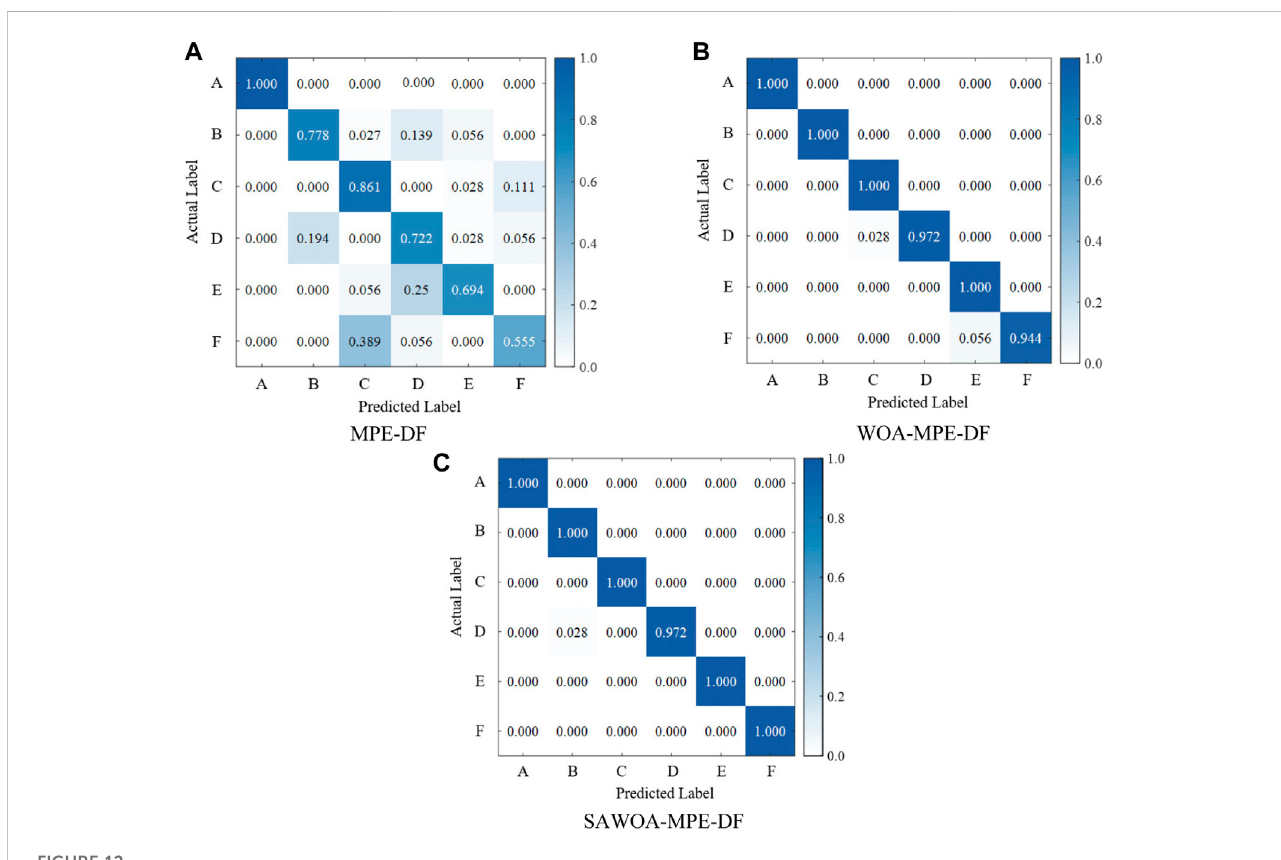
FIGURE 12 Diagnostic results of free-conducting particle faults.